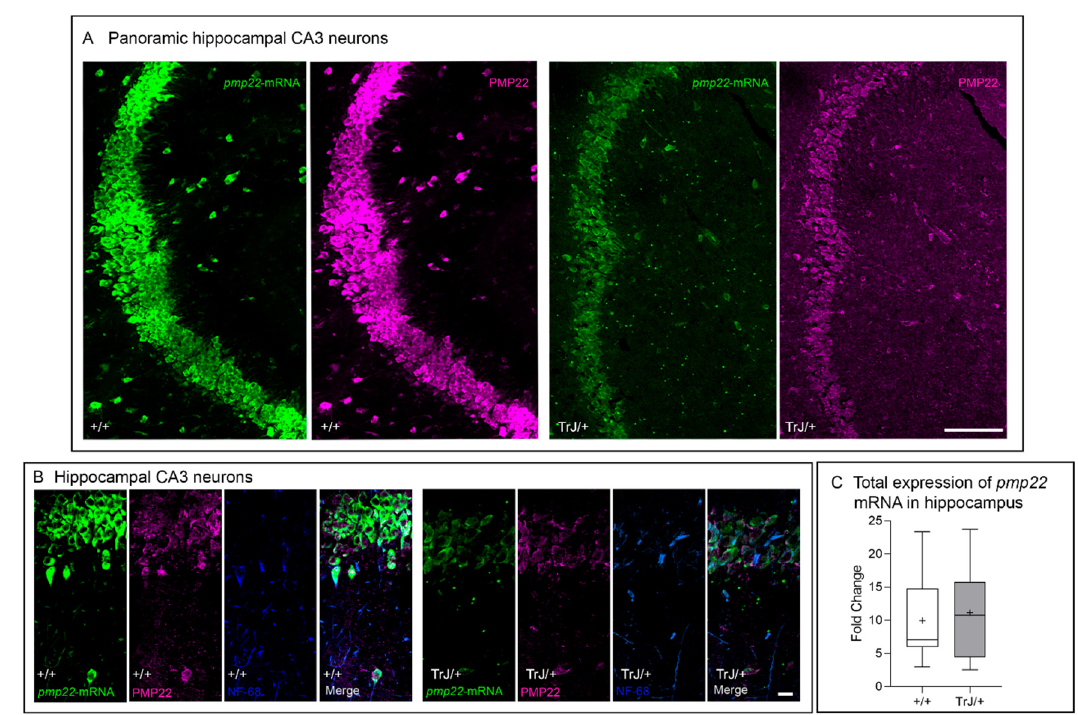
Figure 4. In situ hybridization of pmp22 mRNA and associated PMP22 immunostaining in adult hippocampal CA3 neurons. ( A ) A panoramic view of the CA3 hippocampal regions show the ISH pmp22 signal (green) and their associated PMP22 (soluble form of protein) (magenta) in +/+ and TrJ/+ genotypes. ( B ) In situ hybridization of pmp22 mRNA in hippocampal adult CA3 neurons of +/+ and TrJ/+ mice brains, showing the pmp22 transcript was detected in +/+ and TrJ/+ brain cryosections at the hippocampal CA3 region. The hybrid signals were observed in nuclear and perinuclear domains. Moreover, correlative post-ISH immunostaining of PMP22 and NF-68 may be observed. The upper panel shows +/+ and the lower panel shows the TrJ/+ fluorescence intensity of hybrid and proteins. ( C ) Hippocampal pmp22 mRNA expression in +/+ y TrJ/+ mice was determined by RT-qPCR. Comparative analysis between +/+ and TrJ/+ hippocampi shows no significant differences (Student’s t -test, p = 0.62, n = 3 for each genotype). mRNA levels were normalized against β -actin mRNA. “+”: mean. The mean is shown as “+”. Scale bar for A = 50 µm for all panels. Scale bar for B = 5 µm for all panels.